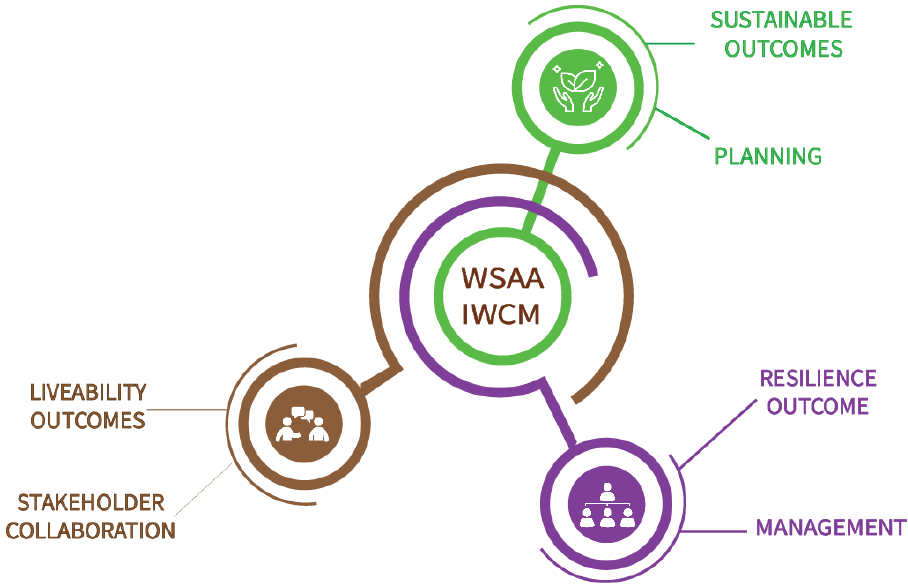
Figure 11. IWCM by WSAA, Australia.